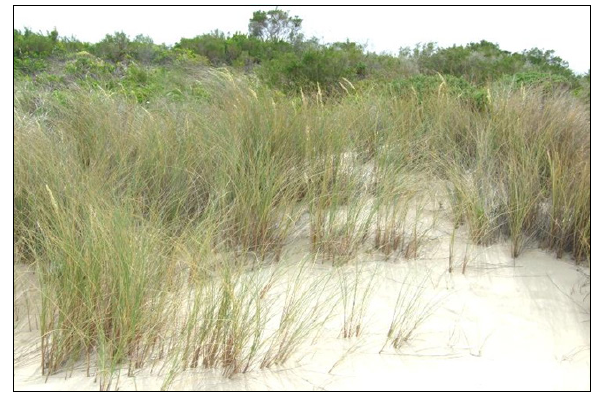
Ammophila arenaria (marram grass) at Oyster Bay being replaced by shrubs with coastal scrub in the distance. Dr Ursula Higgins (née Hertling), a PhD student from Germany, now head of the Research Support Division at the University of Bayreuth, did an extensive survey of the eastern, southern and western Cape coasts in the mid-1990s, and this provided reliable baseline data on the previous extent of marram grass plantings. 3 These data were used by Roy Lubke